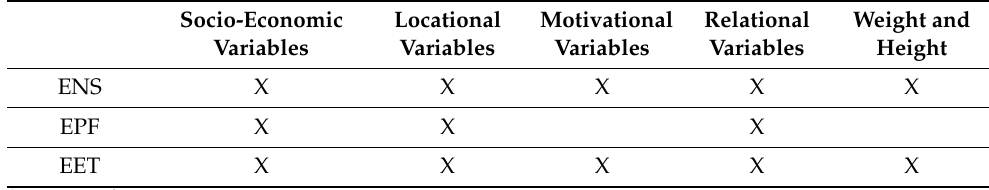
Table 1. Types of variables in the ENS National Health Survey, the EPF Household Budgeting Survey, and the EET Time Use